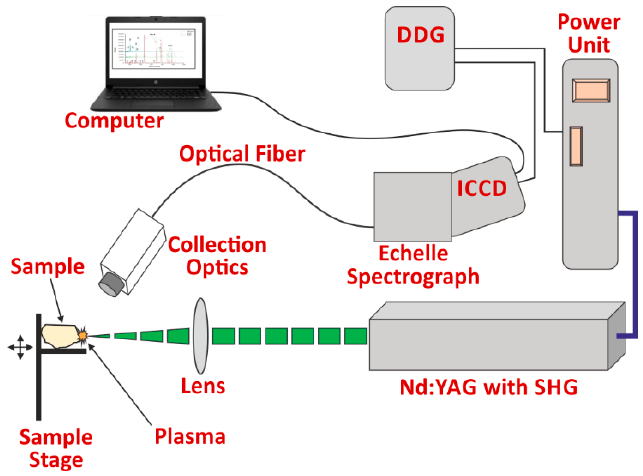
Figure 2. Experimental setup to record LIB spectra of gemstone samples.